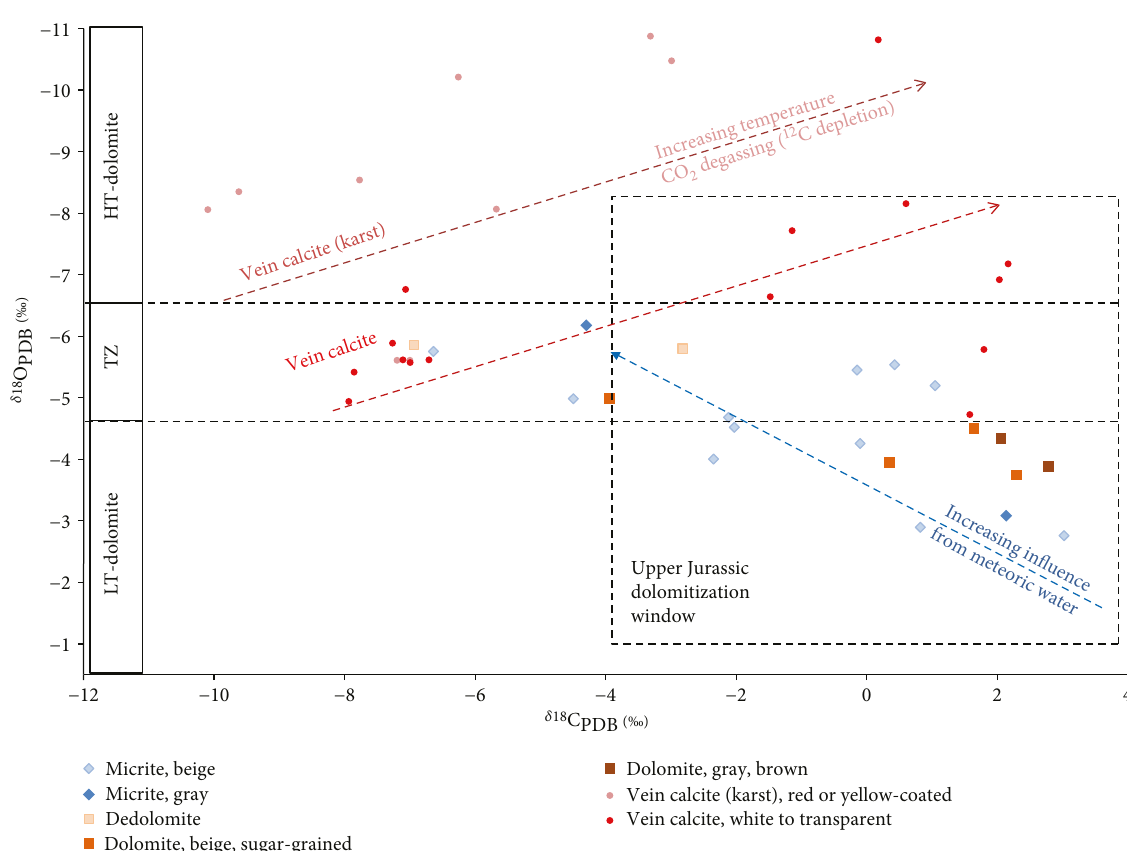
Figure 10: Oxygen and carbon isotopes of Upper Jurassic carbonate rocks from outcrops of the Franconian and Swabian Alb. Dashed window — Upper Jurassic dolomitization window according to Reinhold [17]. LT: low-temperature dolomites; HT: high-temperature dolomites; TZ: transition zone according to Allan and Wiggins [54]. The arrow lines with a trend of increasing meteoric in fl uence according to Liedmann